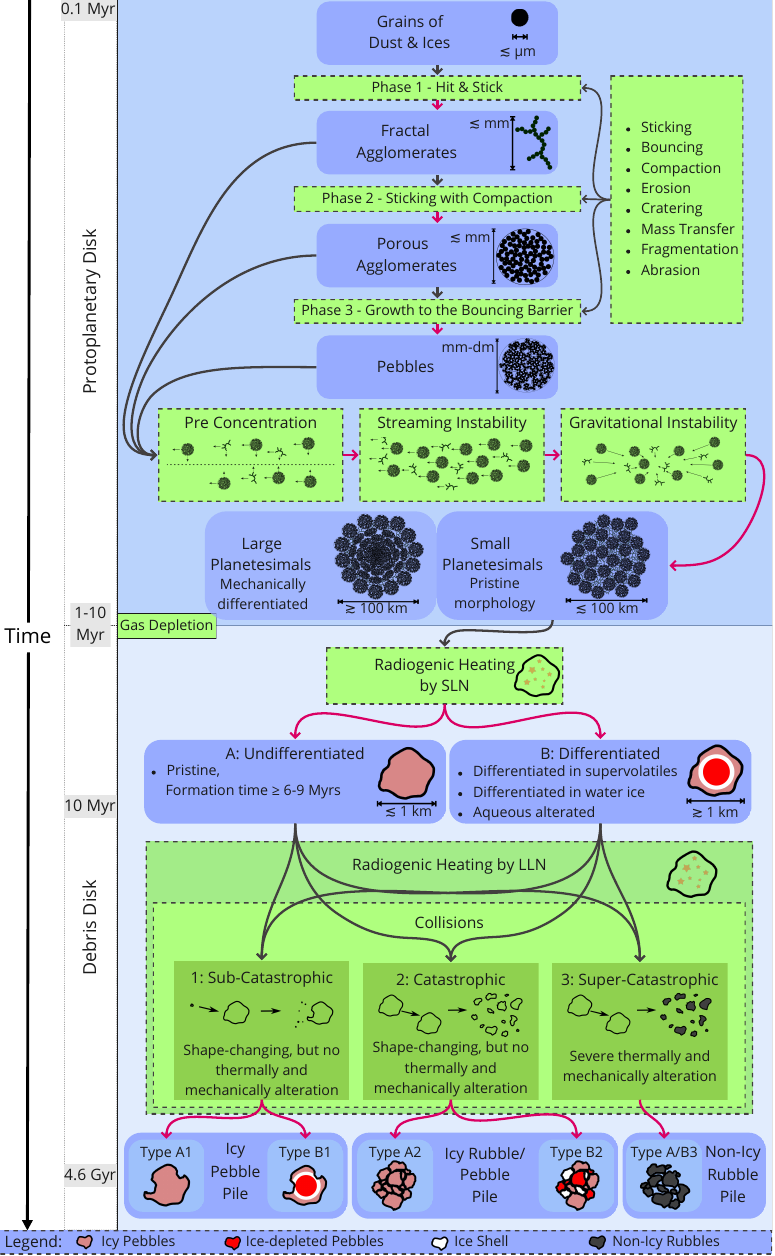
Figure 1. This overview is a graphical representation of the formation and evolution of planetes- imals beyond the H 2 O snowline. The blue and green backgrounds denote objects and processes, respectively. Each step is explained and discussed in the paper. A detailed version can be found at https://www.tu-braunschweig.de/fileadmin/Redaktionsgruppen/Institute_Fakultaet_5/IGEP/AG_ Blum/Comet_Formation_detailed.pdf (accessed on 5 May 2022) and in the Supplementary